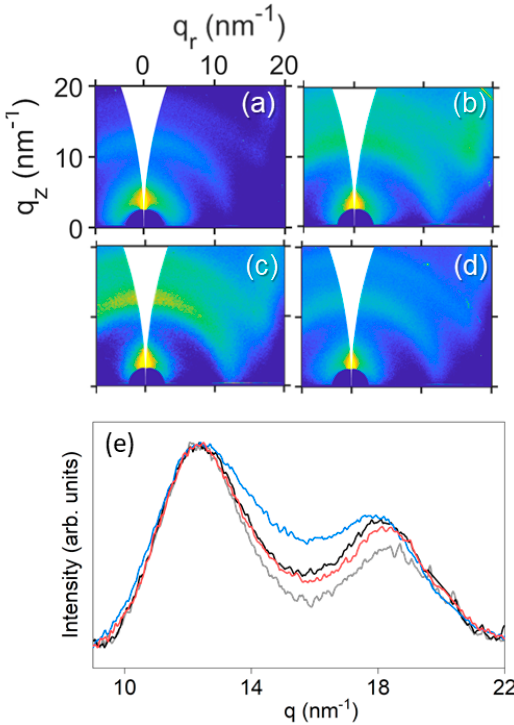
Figure 7. 2D GIWAXS patterns from PEDOT:PSS thin films: ( a ) pure, ( b ) 4EG, ( c ) 10G, and ( d ) 10G+DMSO. ( e ) Azimuthal integrations of 2D GIWAXS patterns from pure PEDOT:PSS (gray curve), 4EG (black curve), 10G (blue curve), 10GDMSO (red curve).